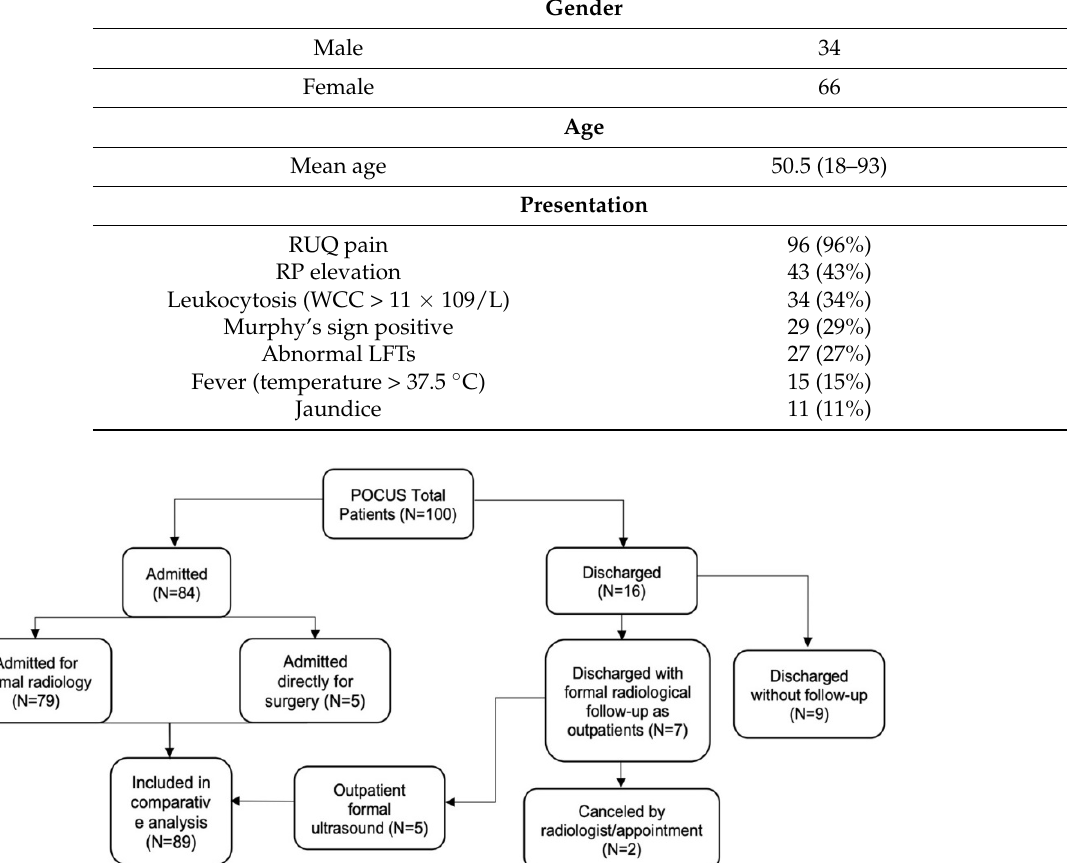
Figure 2. CONSORT Figure 2. CONSORT diagram.